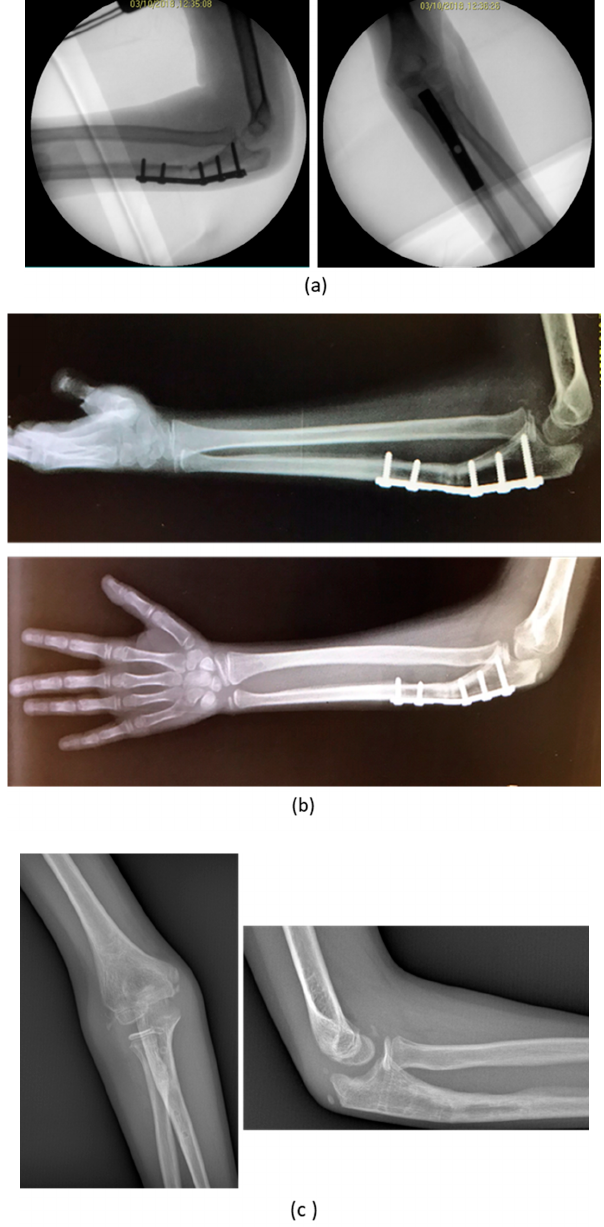
Figure 7. Antero-posterior and lateral radiographs ( a ) intraoperative fluoroscopy; ( b ) at two months of follow-up; ( c ) after the hardware removal, one year later.